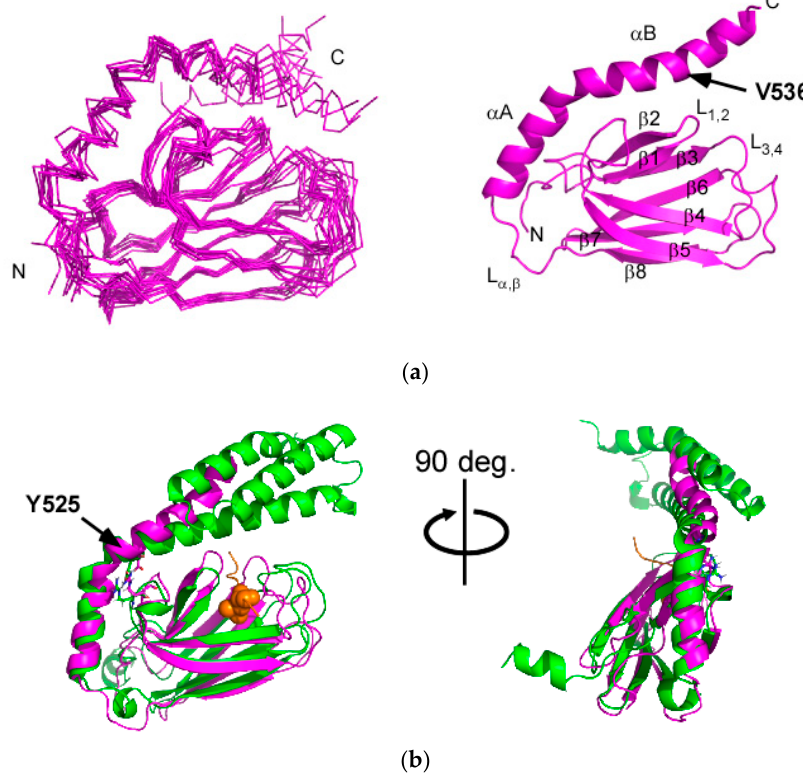
Figure 3. Solution structure of SBD( ∆ CDE)-y of human Hsp70. ( a ) Superposition of the 10 lowest-energy structures of SBD( ∆ CDE)-y with omission of the unstructured parts (residues 382–392 and 546–564) for clarity ( left ). Ribbon representation of the lowest-energy structure of SBD( ∆ CDE)-y ( right ); ( b ) Superposition of ribbon representations of the NMR structure of SBD( ∆ CDE)-y (magenta) and the crystal structure of the NR-peptide-bound form SBD in Hsp70 (PDB ID: 4PO2) (green). Two different views are provided. Residue L5 of the NR-peptide is shown by orange spheres [15].